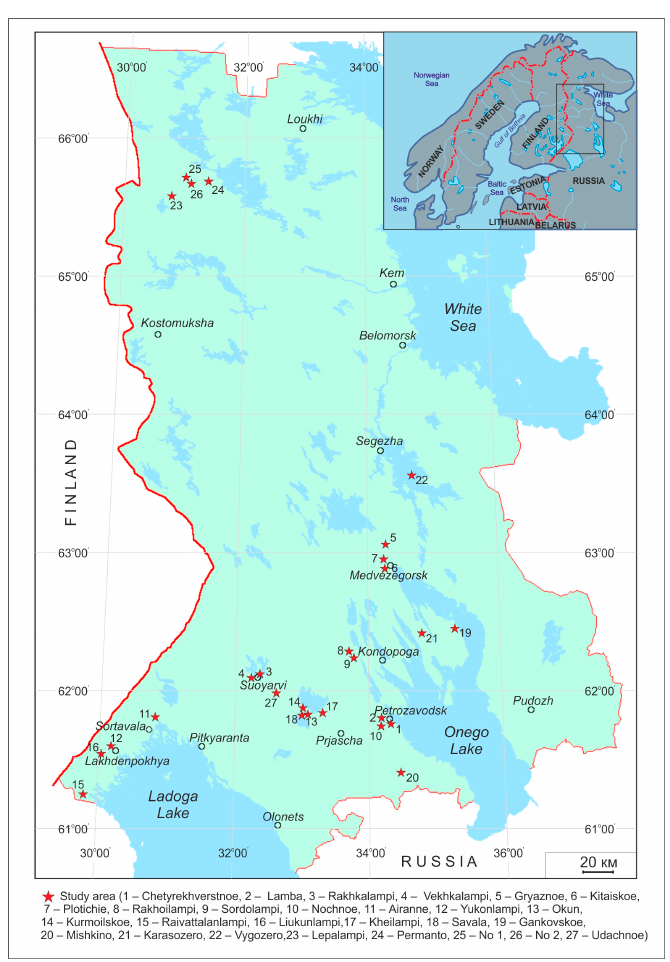
Figure 1. Study area showing sampling locations of lake sediments.